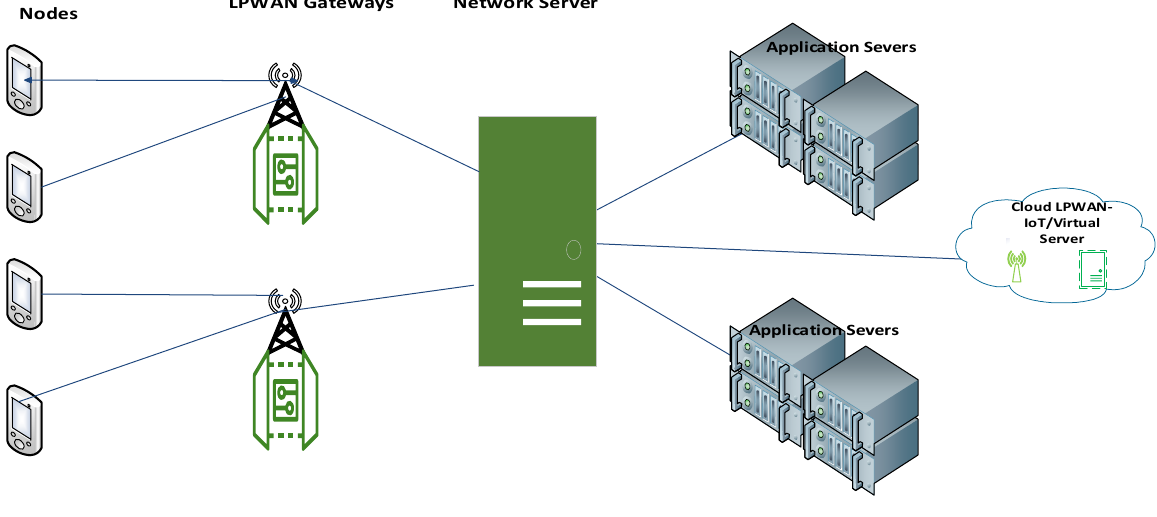
Figure 4. Typical LPWAN Architecture.